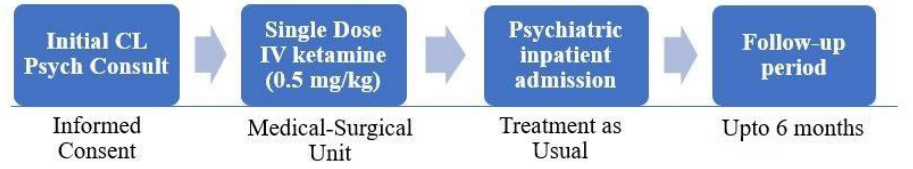
Figure 1. Overview of study design.